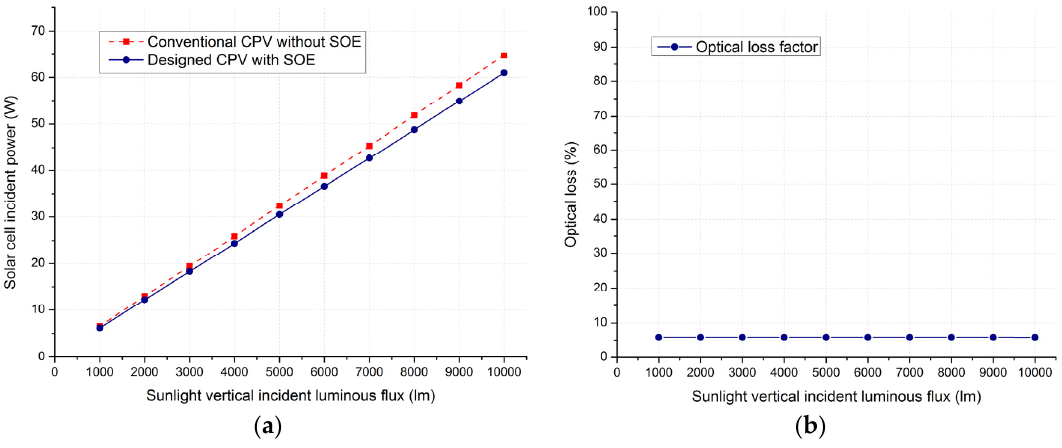
Figure 8. ( a ) comparison of incident power received at the cells of the conventional and proposed CPV units; and ( b ) optical loss of the proposed CPV unit compared to the conventional CPV unit.